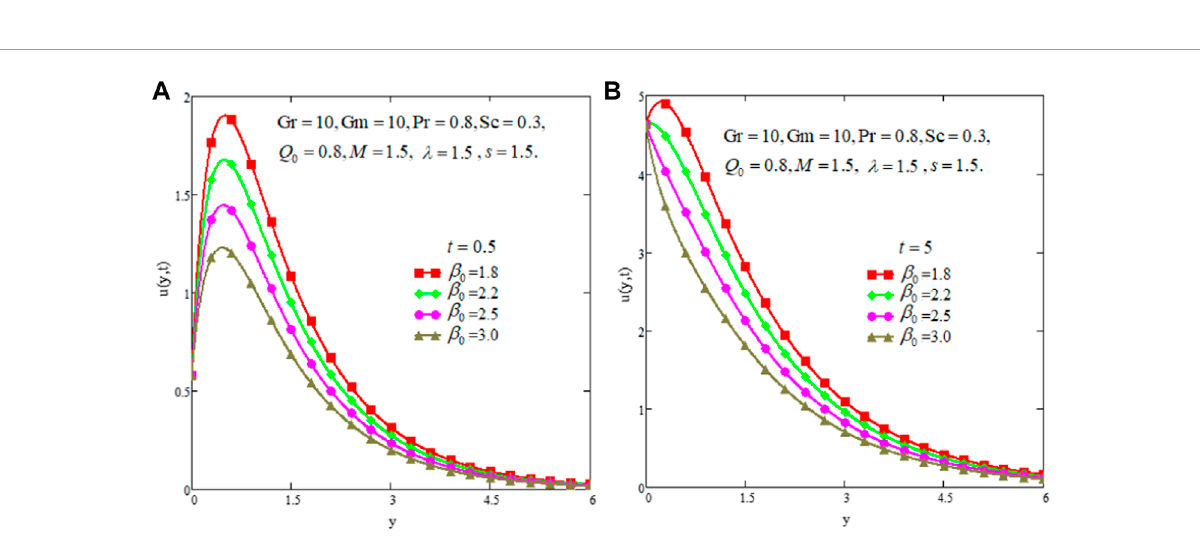
FIGURE 9 Velocity profile due to β 0 variation for small time (A) and for large time (B) .